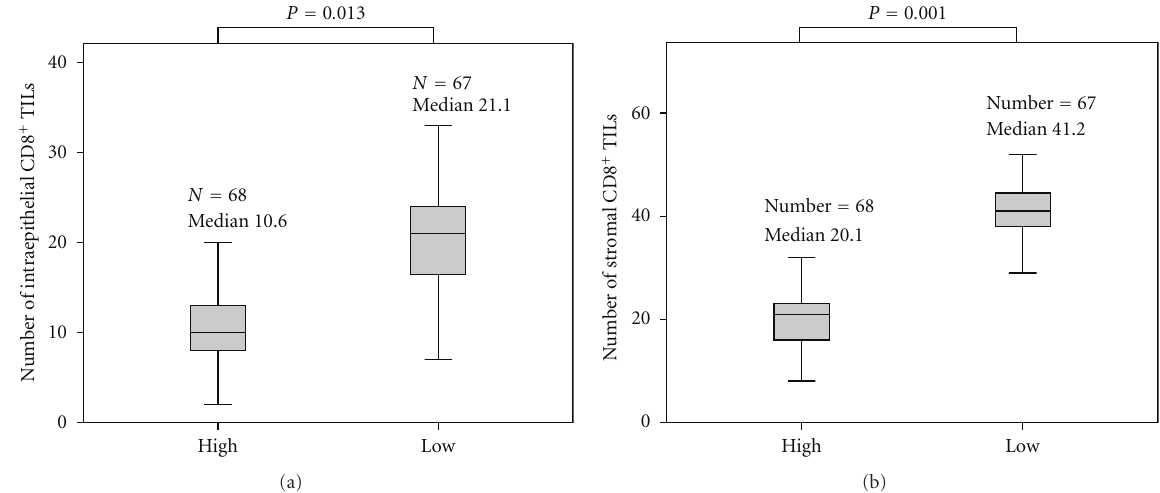
Figure 2: Association of IDO expression with the number of CD8 + TILs. There was a significant di ff erence in both the number of intraepithelial CD8 + TILs (a) and stromal CD8 + TILs (b) between the tissues with IDO-high expression and IDO-low